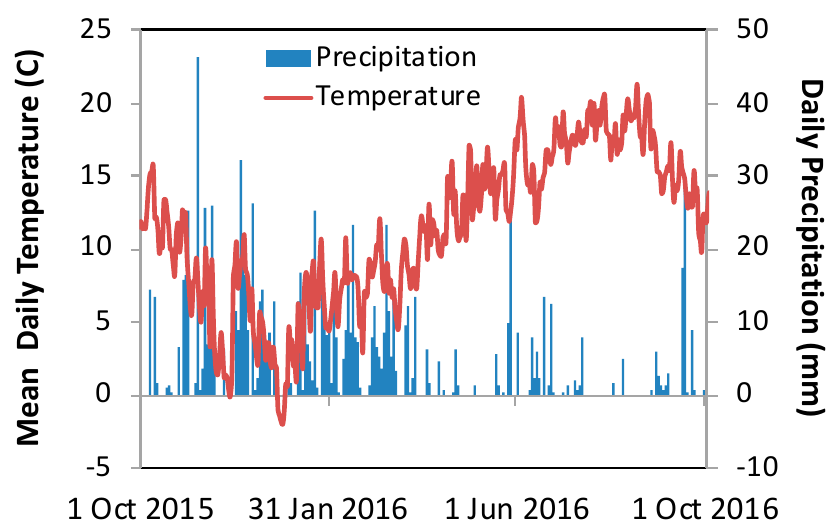
Figure 1. Mean daily temperature and daily precipitation during the study period.